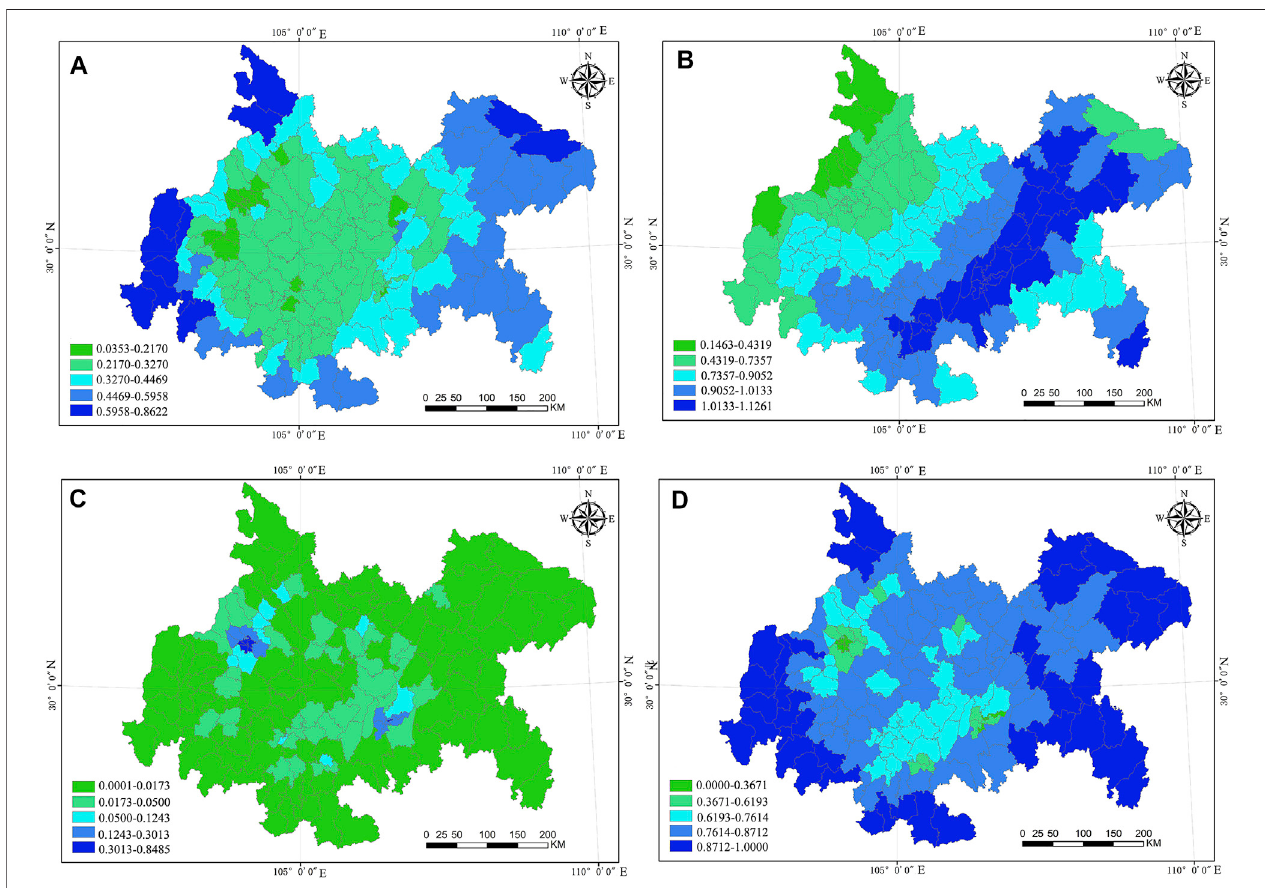
FIGURE 4 | Spatial effect of four kinds of in fl uencing factors (A) . Geomorphological factors; (B) climatic factors; (C) anthropogenic factors; and (D) vegetation factors).